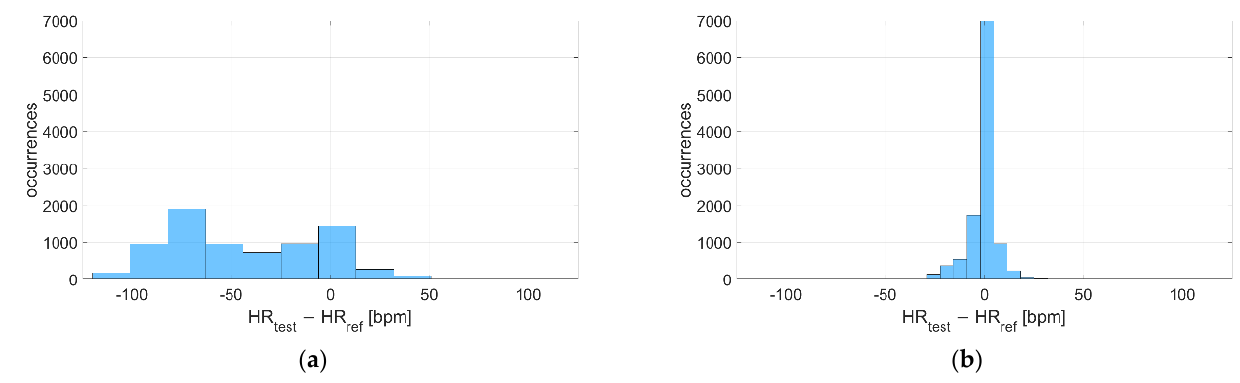
Figure 7. Distribution of deviations related to ( a ) In-water and ( b ) Dry acquisitions, including recordings both at rest and during moderate physical activities performed with Garmin Venu Sq (reference instrument: Polar H10).